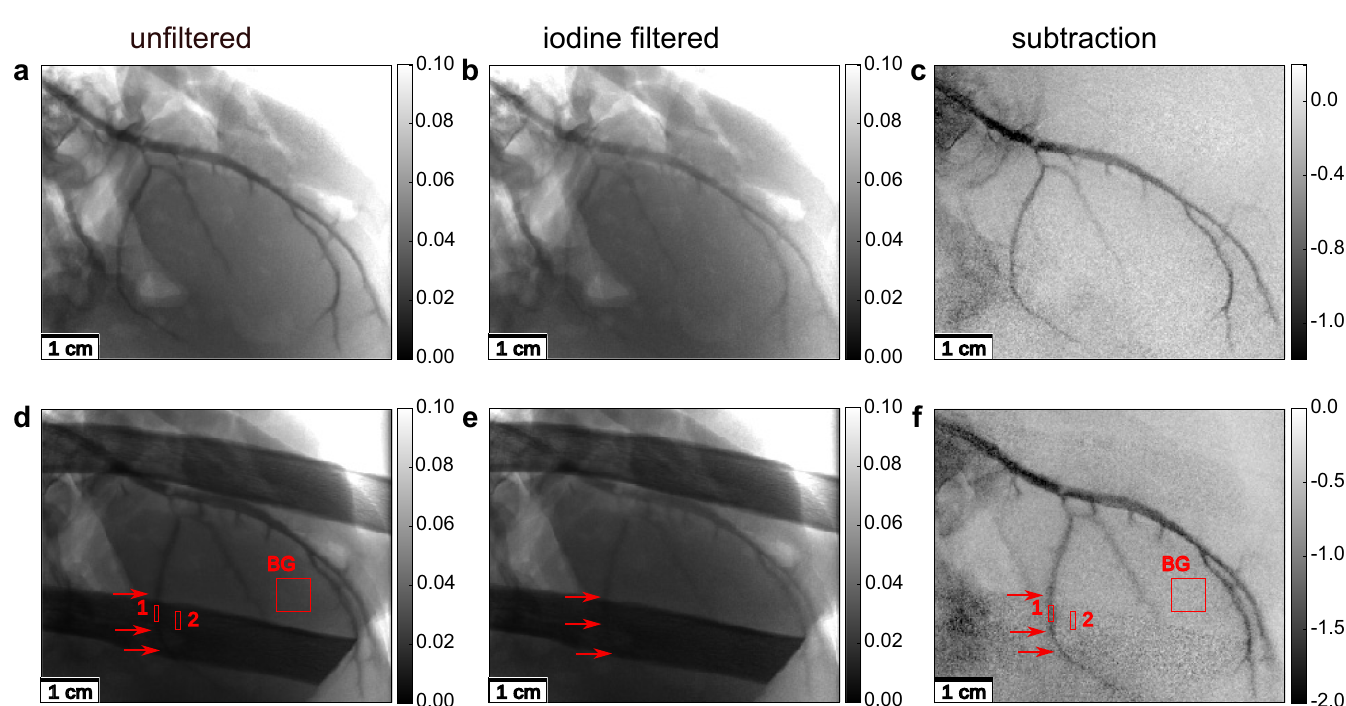
Fig 4. K-edge subtraction imaging of the left anterior descending artery of a porcine heart with injected iodine contrast agent and inhomogeneous background structures : First row: In both, the unfiltered (a) and the iodine-filtered (b) image, air artefacts and inhomogeneous absorption make the identification of small blood vessels difficult. In the KES image (c) , only the contrast agent remains visible; Second row: The overlying bone structures make the identification of the small blood vessel (marked by the red arrow) impossible in images (d) and (e) . Only KES imaging, combined with an energy correction, restores contrast for these blood vessels. Although in areas of lower counting statistics the image quality is compromised in the KES image (f) by noise, the visibility of the small vessels is increased. The ROIs for the calculation on the CNR of the blood vessel (1) and the bone (2) are shown in the unfiltered (d) and difference (f) image. The gray scales of the images were chosen such that the contrast for the coronary arteries is optimized. The gray scales for the unfiltered and filtered images show the relative intensity of the X-ray beam, while the gray values in the KES images show the negative differences in the absorption.